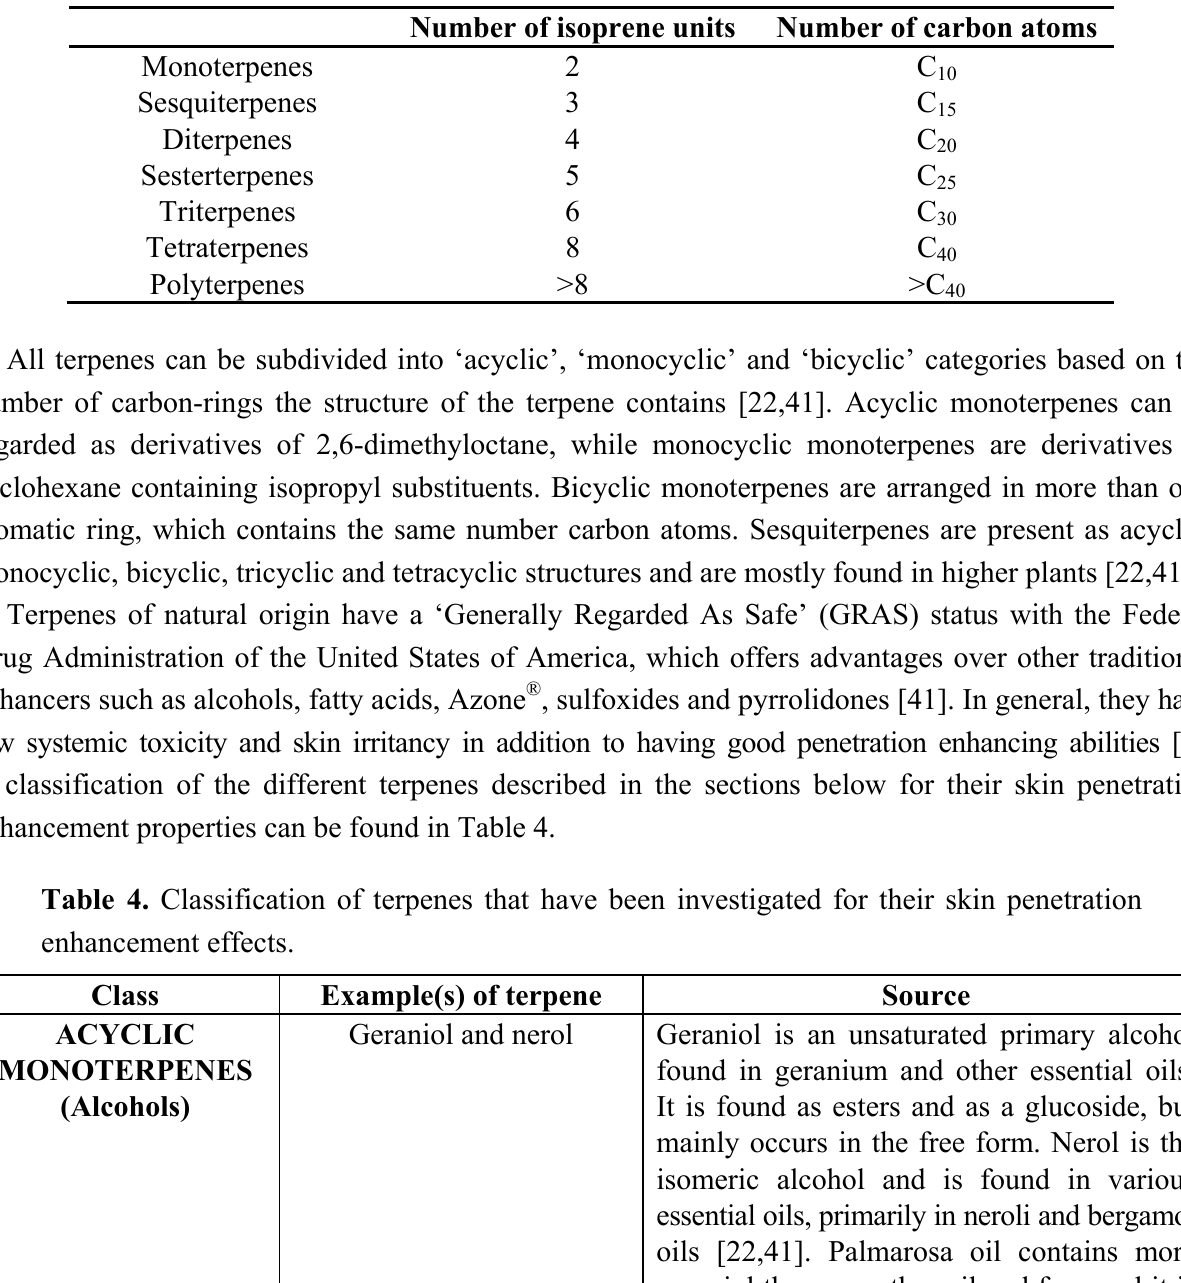
Table 3. Classification of terpenes according to the number of isoprene units [41,44].